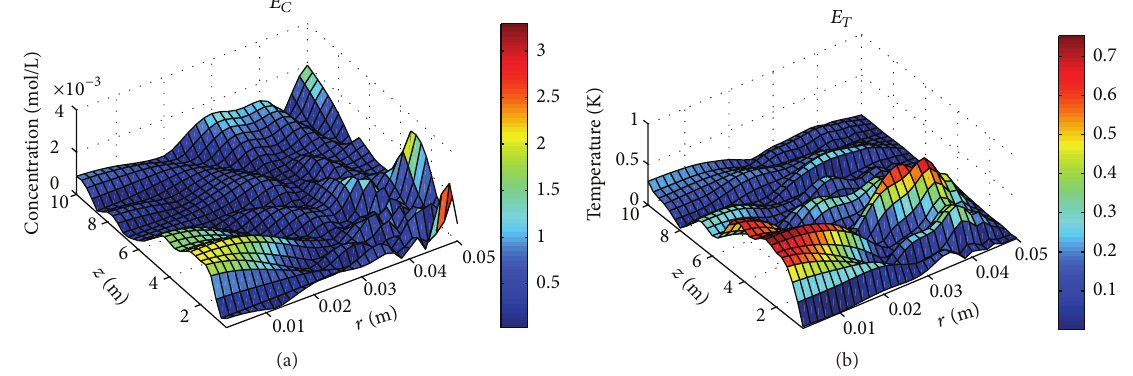
Figure 10: Average of the absolute error between the full-order model (15) and the reduced-order model